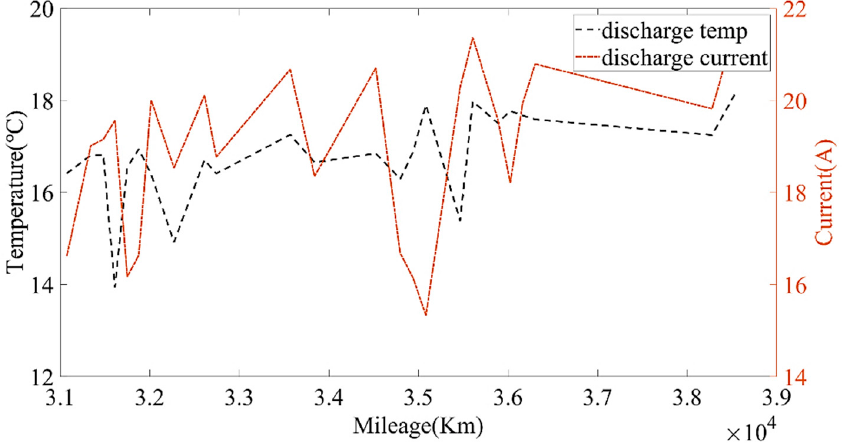
Figure 15. The relationship between the discharging temperature, discharging current and the mileage at the charging temperature of 25 ◦ C.